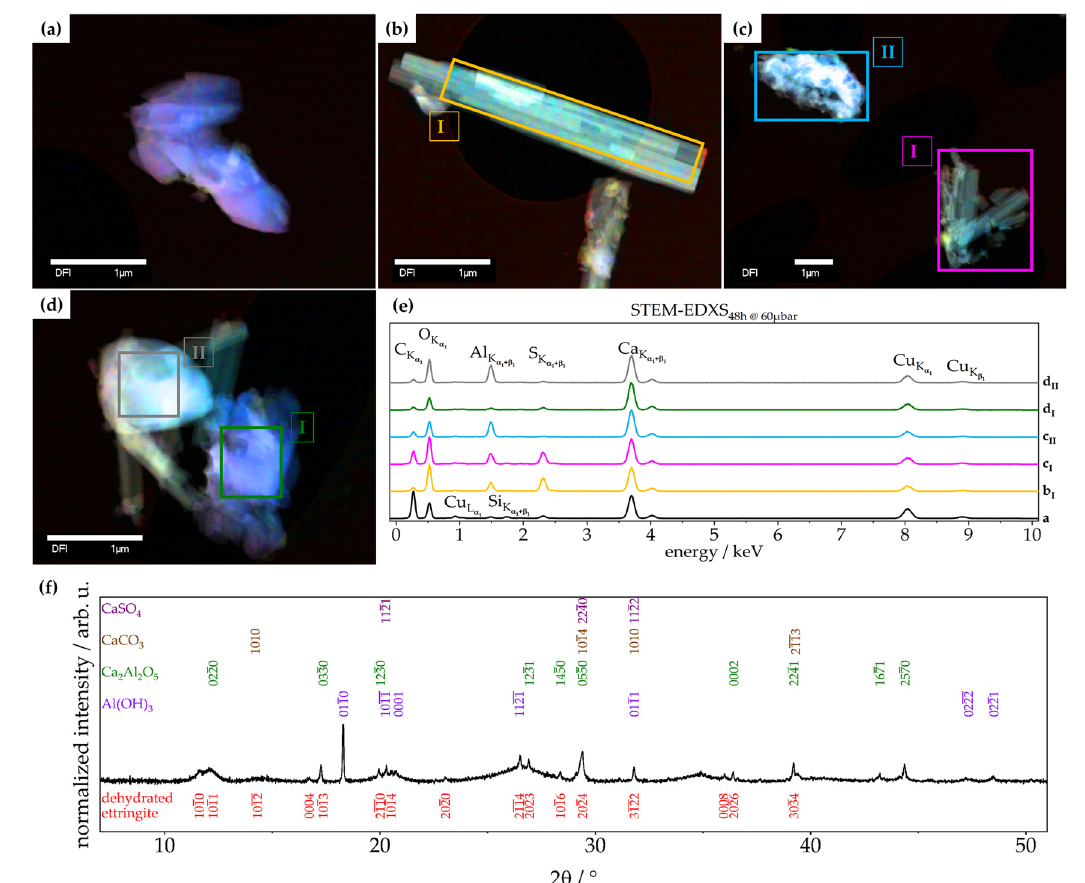
Figure 6. STEM micrograph of ettringite treated at 60 µbar for 48 h; ( a – d ) sites of EDXS and ( e ) STEM-EDXS spectra of different sites; ( f ) X-Ray diffractogram showing identified phases of retrogressed ettringite after treatment at 60 µbar for 48 h; CaCO 3 [35], Ca 2 Al 2 O 5 [36], Al(OH) 3 [37], and CaSO 4 [38].